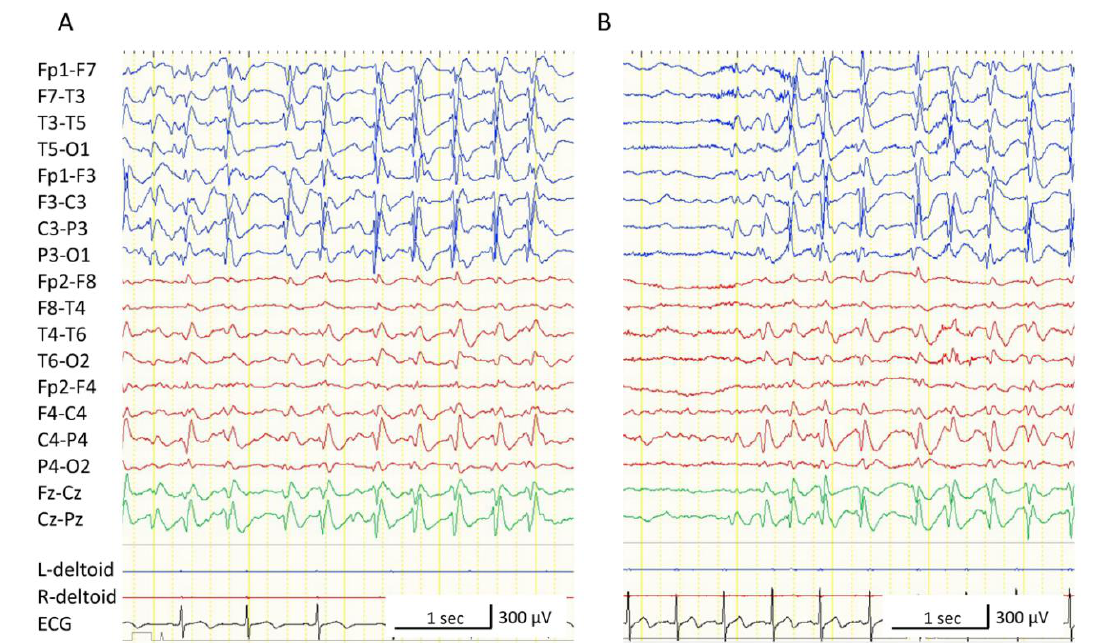
Figure 4. Scalp electroencephalograms (EEG) after the corpus callosotomy. All EEGs were recorded with the following settings: low-cut filter, 1.6 Hz; high-cut filter, 60 Hz. ( A ) Interictal EEG. Epileptiform discharges are lateralized to the left hemisphere. ( B ) Ictal EEG of an absence seizure. Ictal changes are observed in the left hemisphere but not in the right hemisphere.